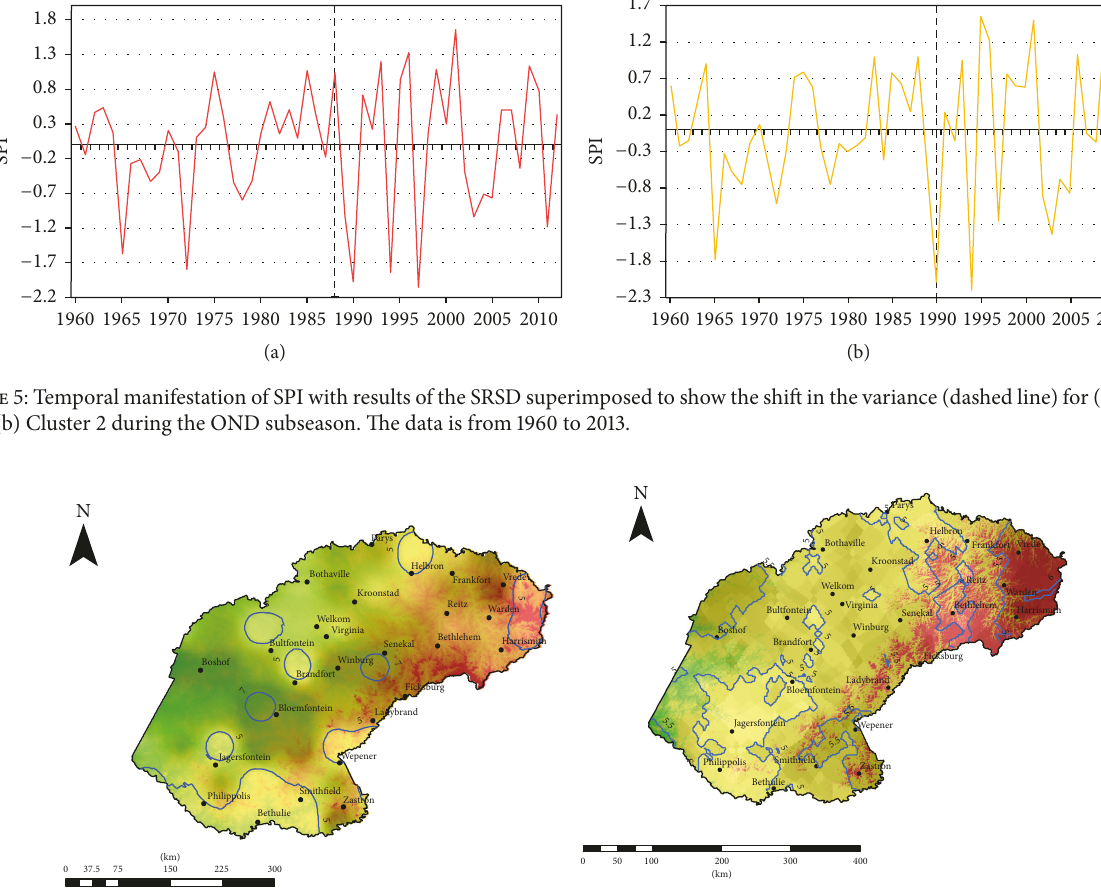
however, the areas prone to severe droughts are to the extreme northeastern tip, the central west, and the extreme southeastern areas of the province (Figure